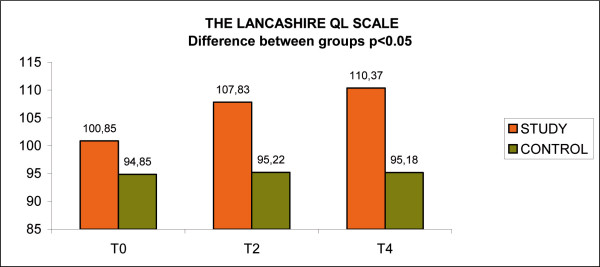
Lancashire QL scale.